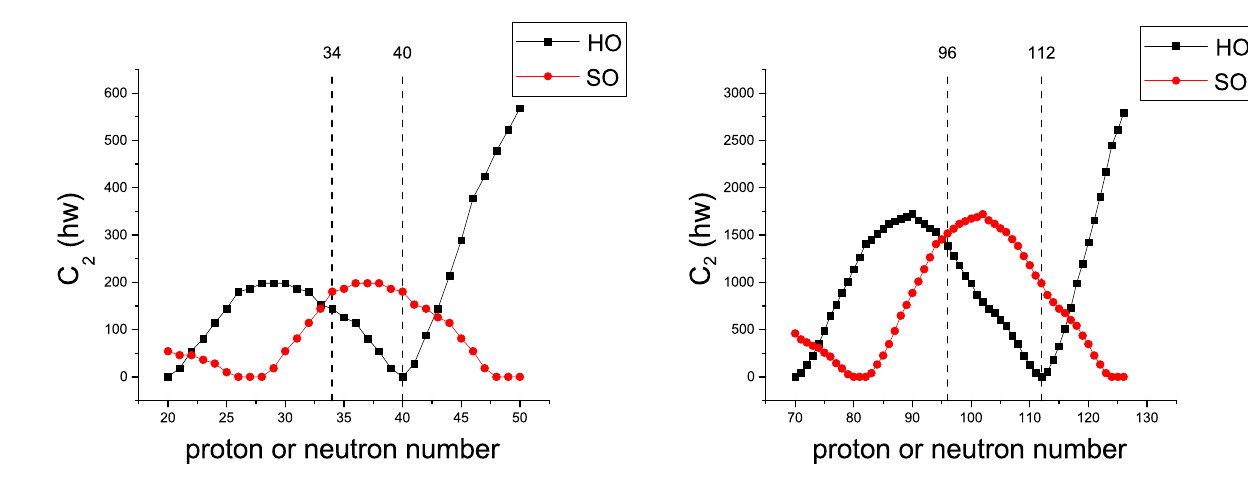
Figure 5. The same as Fig. 1. An island of shape coexistence is predicted within proton or neutron numbers 96 − 112.